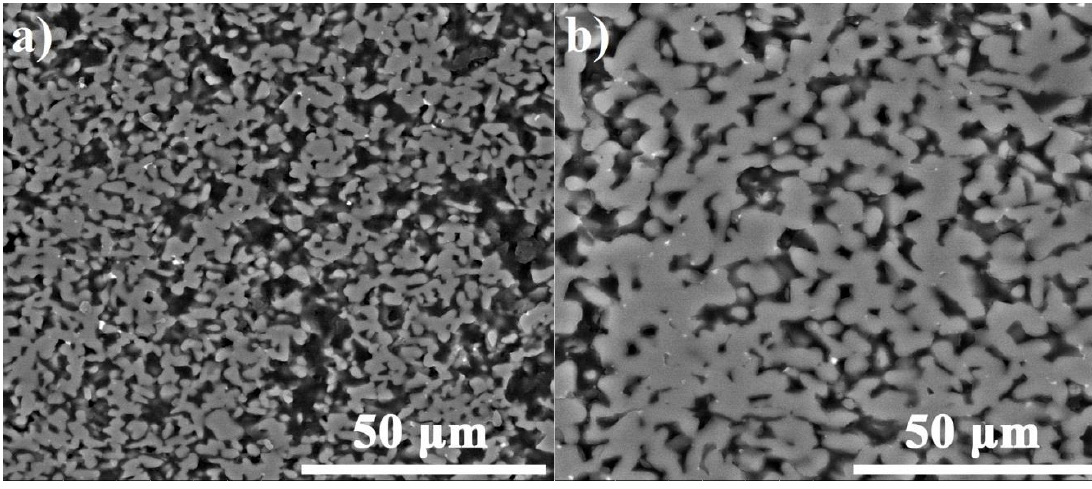
Figure 9. SEM images of the SiC p matrix of the composites sintered at 20 MPa ( a ) and 60 MPa ( b ) for 10 min.